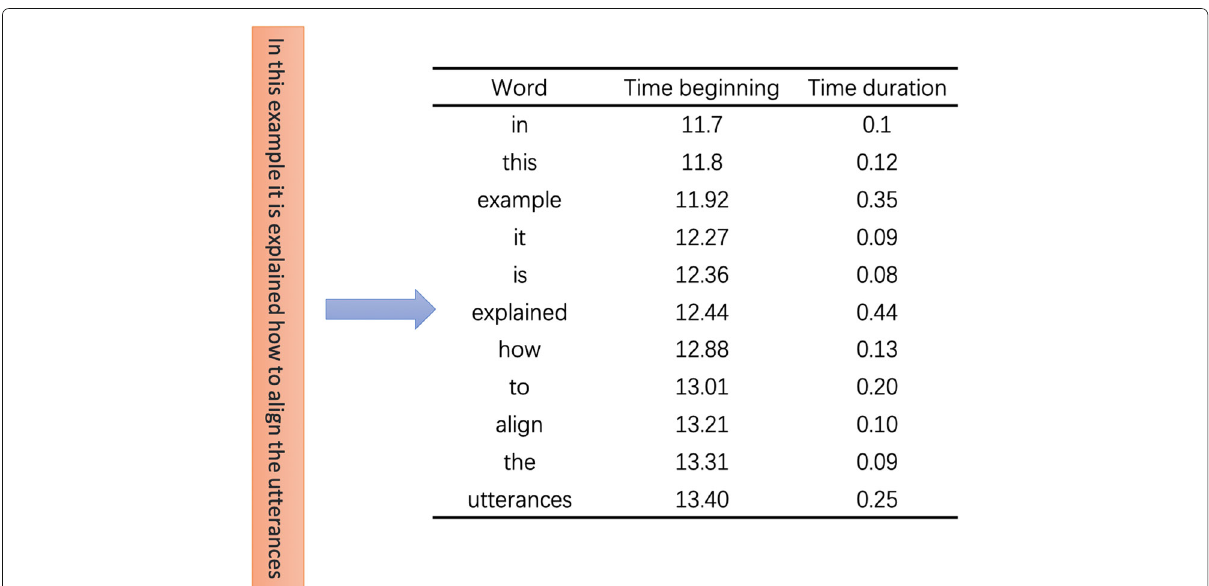
Fig. 6 Example of system output CTM file. Timestamps consist of the starting time and KW duration